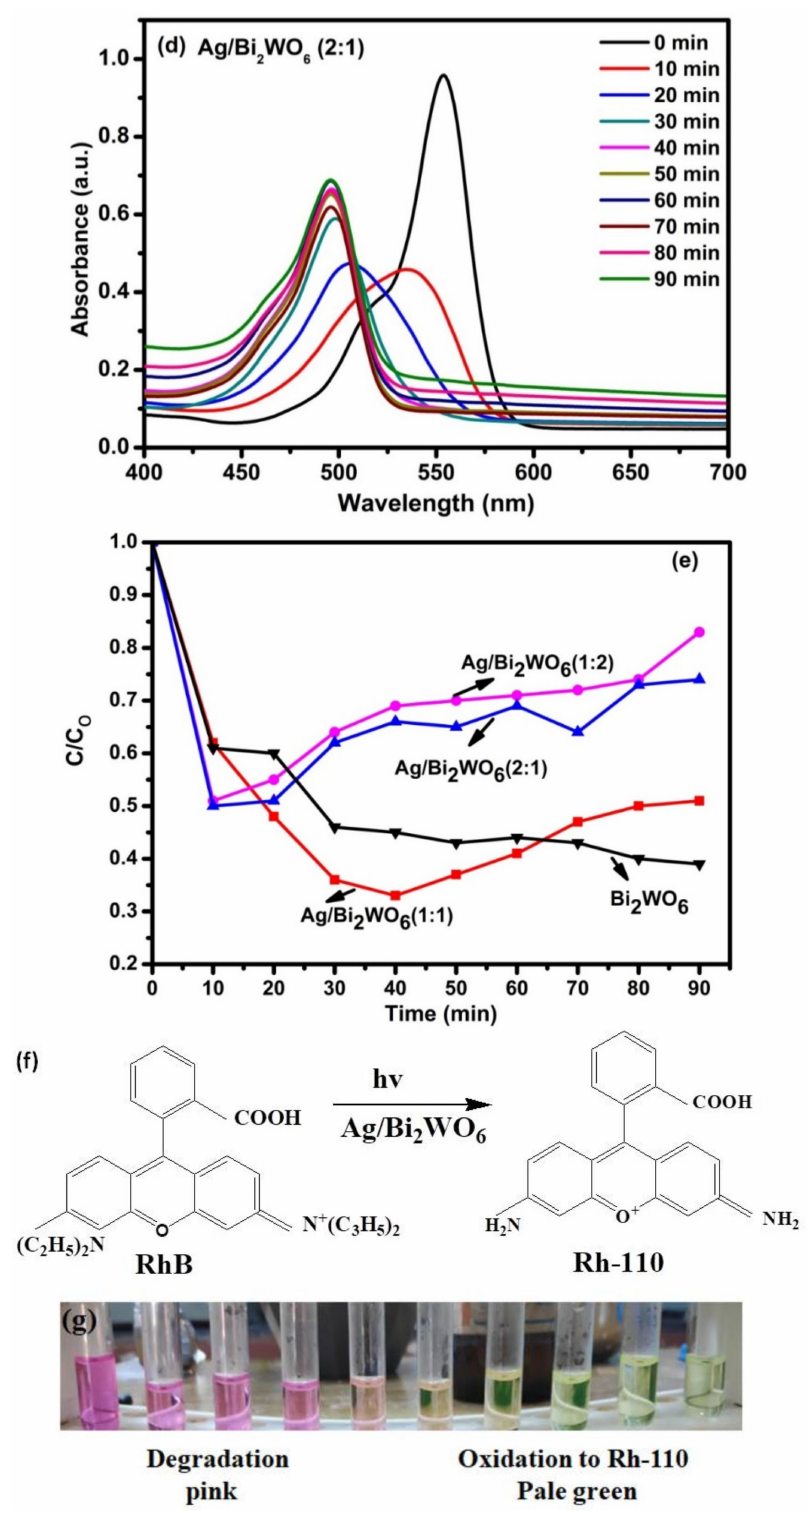
Figure 13. Photocatalytic oxidation of RhB by ( a ) Bi 2 WO 6 , ( b ) Ag/Bi 2 WO 6 (1:1), ( c ) Ag/Bi 2 WO 6 (1:2) and ( d ) Ag/Bi 2 WO 6 (2:1); ( e ) photocatalytic degradation efficiency of the prepared photocatalysts; ( f ) conversion of RhB to Rh-110; and ( g ) images of RhB taken after every 10 min of the reaction. A higher MB removal efficiency of 68% in 90 min was observed with Ag/Bi 2 WO 6 (1:2) (Figure 14c). Pure Bi 2 WO 6 and Ag/Bi 2 WO 6 (1:1 and 2:1) degraded only 38%,